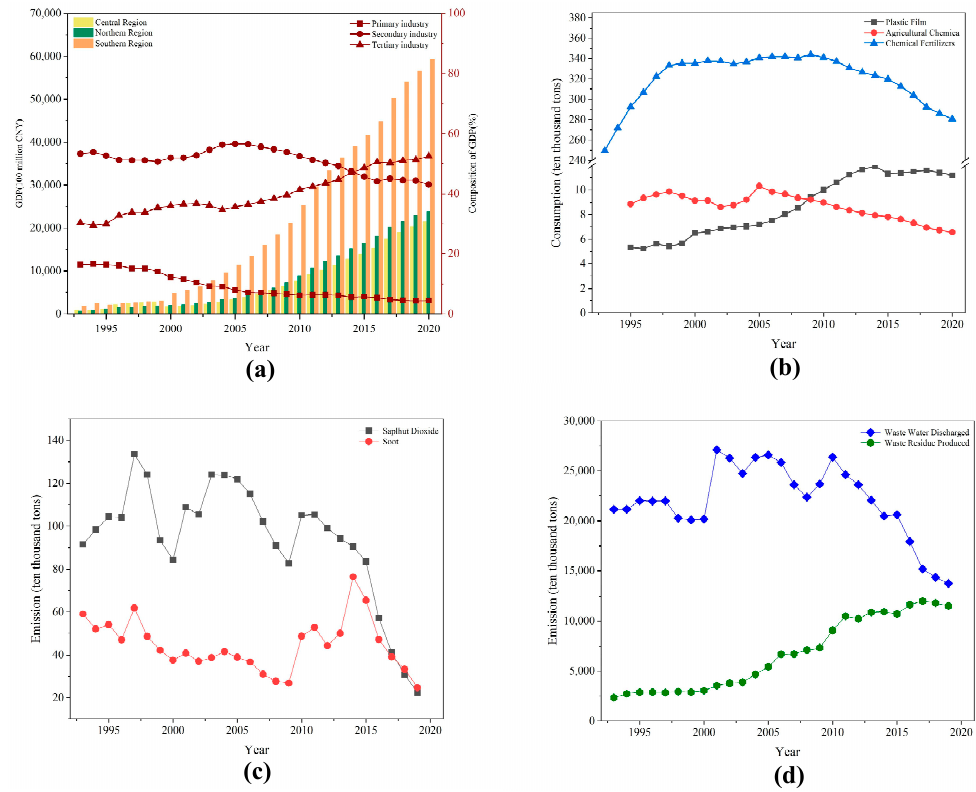
Figure 5. Temporal trends in economic and emission data: ( a ) Annual GDP and composition of different regions in Jiangsu Province; ( b ) annual consumption of agricultural materials; ( c ) annual emissions of sulfur dioxide and soot; ( d ) annual emissions of wastewater and residue.